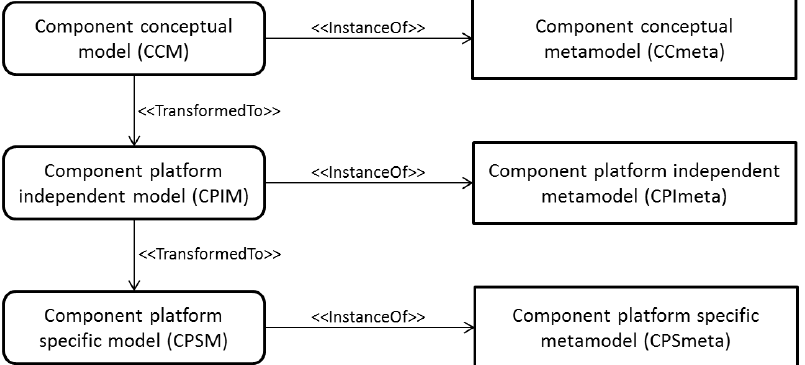
Figure 2. Metamodels and models in CompoMDD process model.